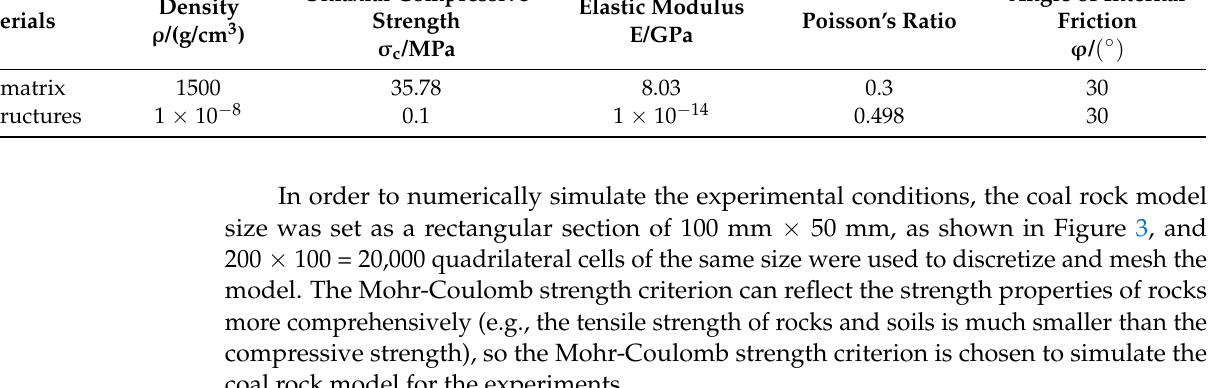
Table 2. Parameters used in RFPA numerical simulation model.